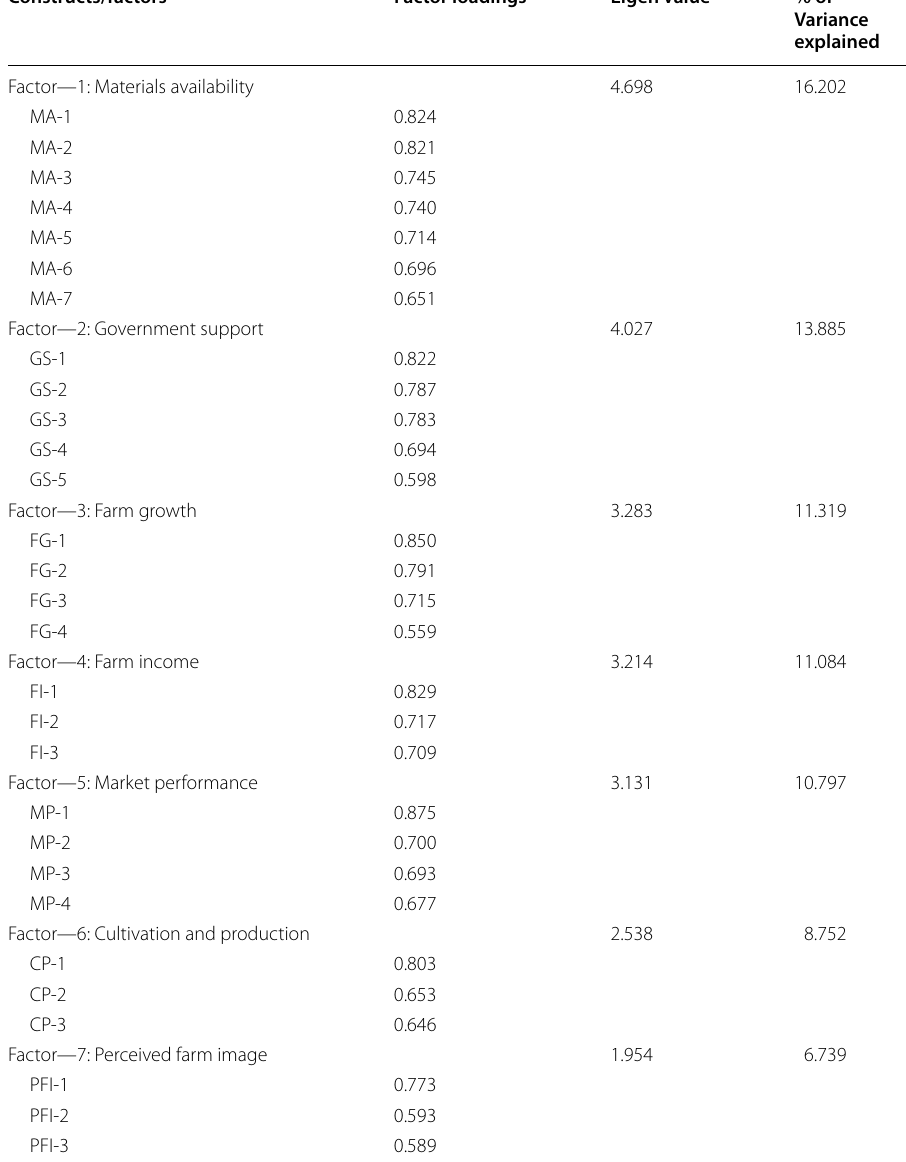
Table 4 Results of exploratory factor analysis